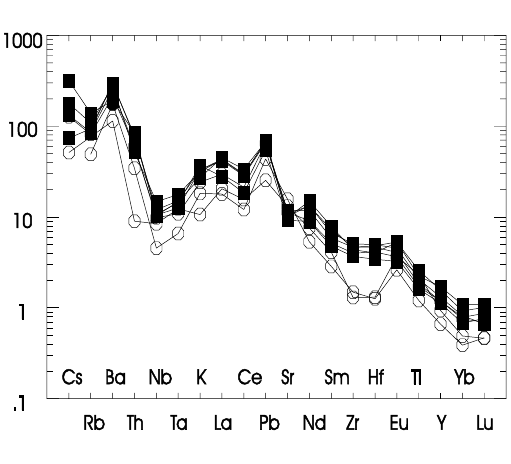
Fig. 3 – AFM-diagram showing a calc-alkalic trend with clear compositionalgap. Somebasicsamplesplotinthetholeiiticfield. Symbols: (cid:2) Opx-gabbro; (cid:3) qz-diorites to qz-monzodiorites; ❒ megagaporphyritic granite.